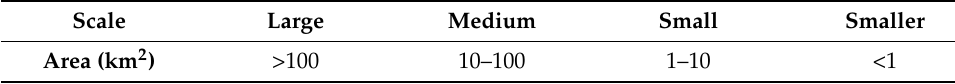
Table 5. The scale classification results of each eco-environment elements.